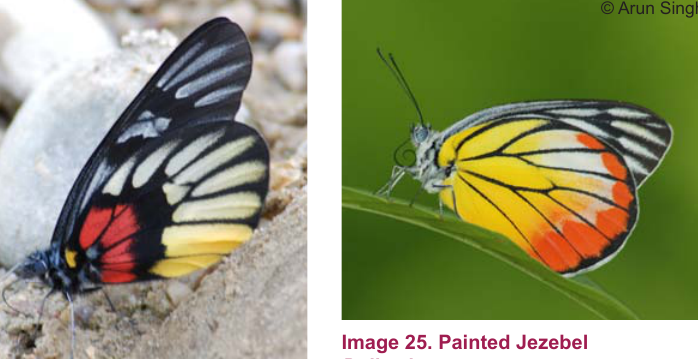
Image 23. Red Spot Jezebel Delias descombesi